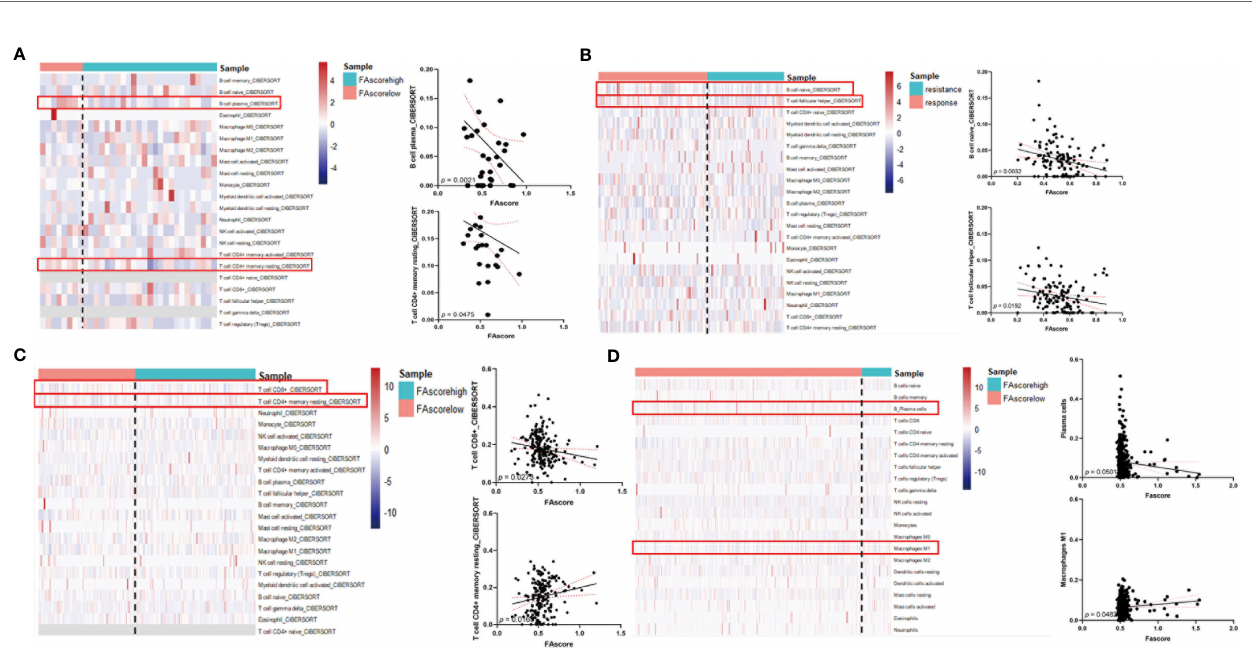
FIGURE 6 | High FAscores indicated a pro-tumor immune microenvironment. Analysis of the correlation between FAscores and the proportions of immune cell subpopulations in different cohorts, including the training cohort (A) , GSE14210 cohort (B) , Peking University Cancer Hospital (PKUCH) cohort (C) , and the Cancer Genome Atlas (TCGA) cohort (D) . The results showed that high FAscores indicated an decrease in the ratio of anti-tumor immune